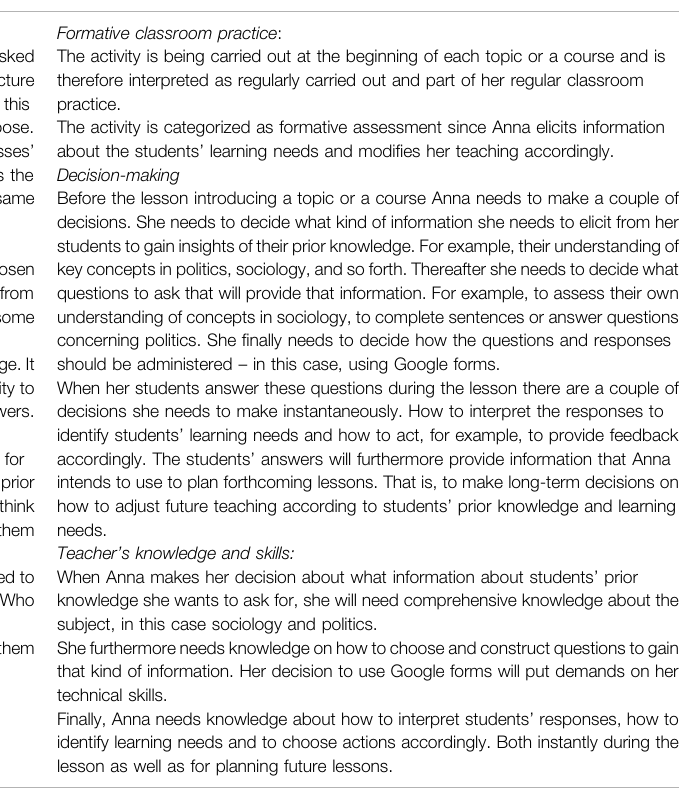
TABLE 1 | Example of the